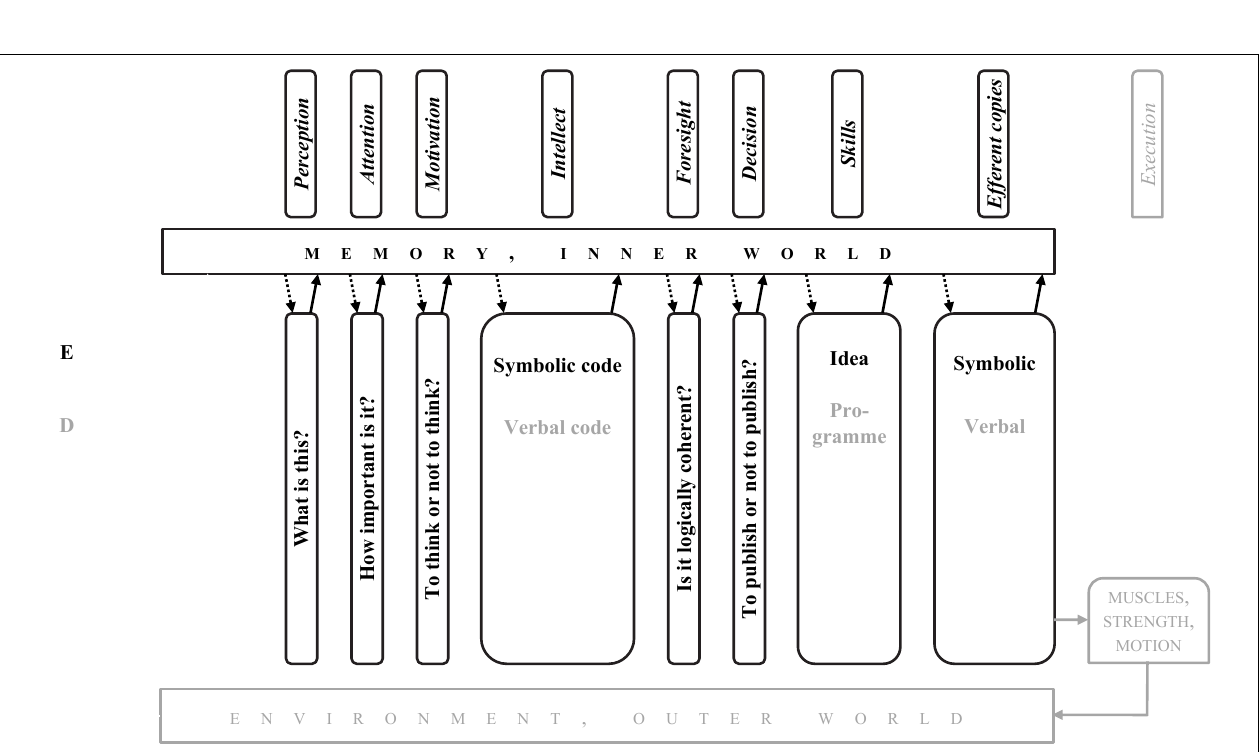
Frontiers in Psychology |